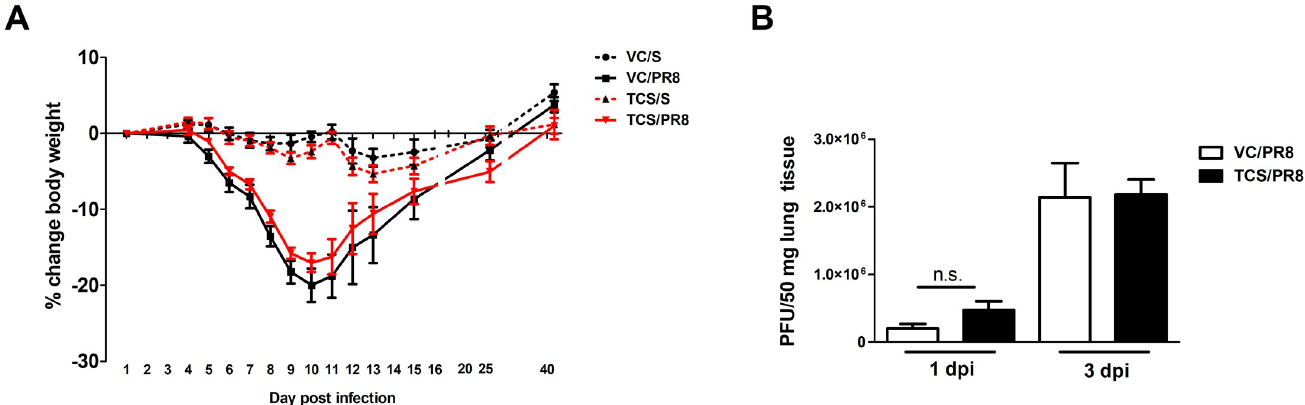
Fig 2. Morbidity and viral titers are unaltered by TCS. Mice treated with VC or TCS were intranasally infected with 50 pfu of PR8 or mock infected with S, as outlined in Fig 1. A) Mice were weighed throughout the course of infection and percent weight change was calculated based on starting weights n = 10 mice/group (through day 10 and 5 mice/group thereafter). B) Viral titers were assessed via plaque assays of lung tissue and calculated as plaques per 50 mg of lung tissue. N = 5 mice per group. No changes in body weights or viral titers due to TCS exposure were detected.